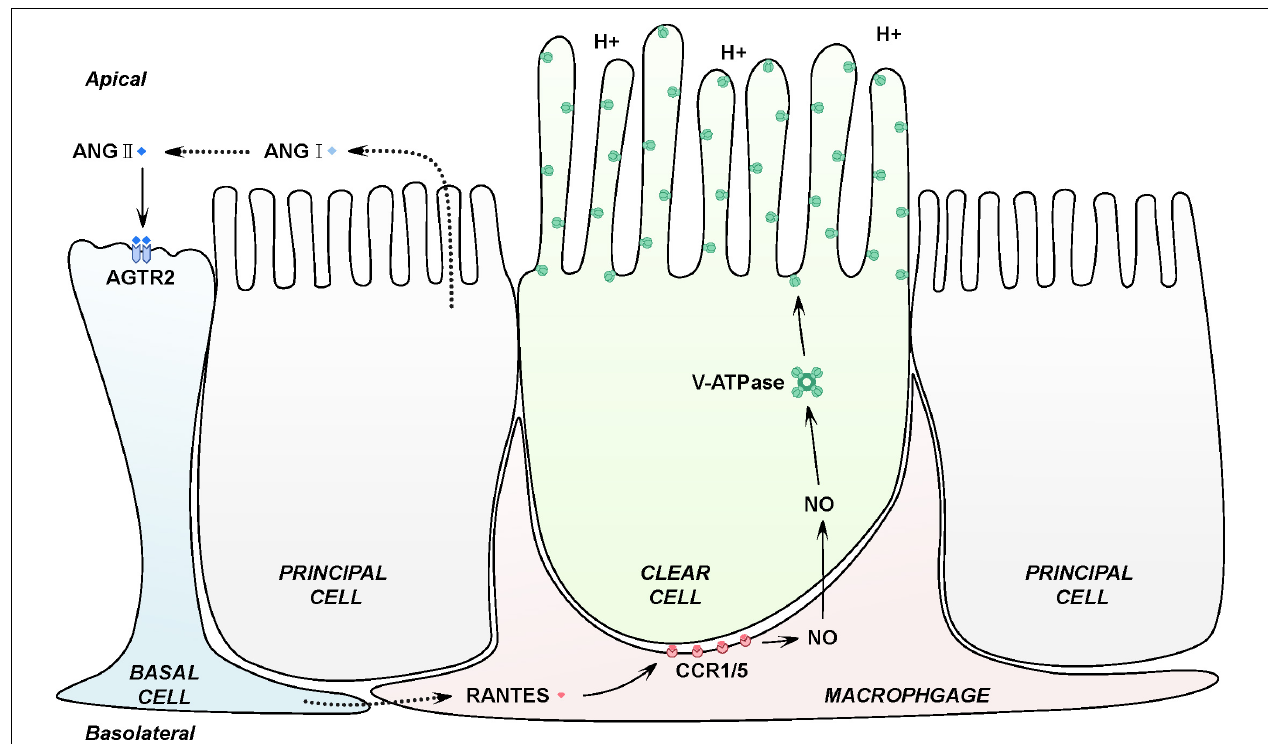
FIGURE 6 | Schematic representation of RANTES in the basal macrophages contributing to the intricate luminal acidic regulation in the epididymis. Firstly, epididymal luminal ANG II binds with its receptors AGTR2 expressed on the membrane of basal cells, inducing the expression of RANTES and its receptors, CCR1 and CCR5 in the basal macrophages. Secondly, RANTES could function with CCR1 and CCR5 to increase the expression of iNOs, which will lead to the up-regulation of NO. Finally, NO will diffuse to the adjacent clear cells to stimulate the expression of V-ATPase, causing the increased secretion of proton to the epididymal lumen to maintain the normal acidic